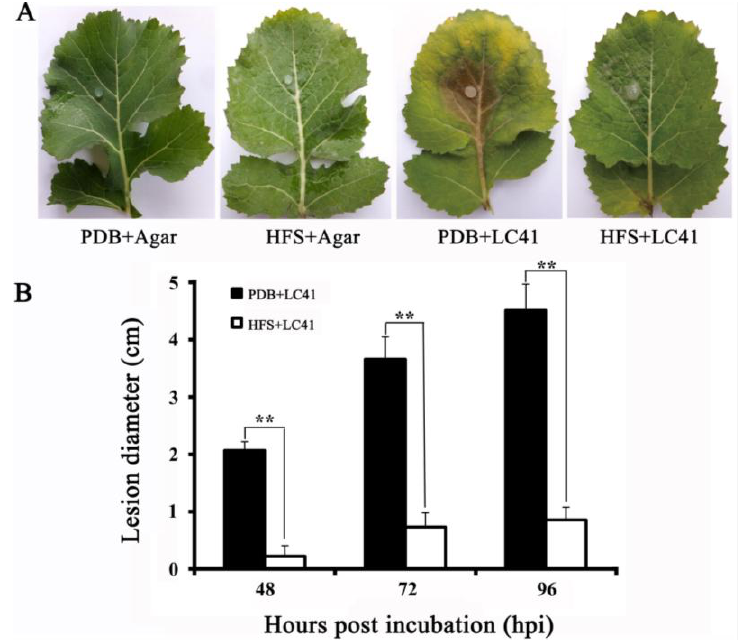
Figure 5. Effect of pre-treatment of oilseed rape leaves with the hyphal fragment suspension (HFS) of the hypovirulent strain LC22 of Sclerotinia minor on infection by the virulent strain LC41 of S. minor . ( A ) Lesions caused by strain LC41 at 96 h post inoculation (20 °C) on leaves of different treatments. PDB + Agar, the leaf was pre-treated with potato dextrose broth (PDB) alone and challenge-inoculated with a fresh PDA plug; HFS + Agar, the leaf was pre-treated with the HFS of LC22 alone and challenge-inoculated with a fresh PDA agar; PDB + LC41, the leaf was pre-treated with PDB alone and challenge-inoculated with a mycelial agar plug of LC41; HFS + LC41, the leaf was pre-treated with the HFS of LC22 and challenge-inoculated with a mycelial agar plug of LC41; ( B ) A histograph showing average leaf lesion diameters ( n = 18) of different treatments. ** p < 0.01, Student’s t test.